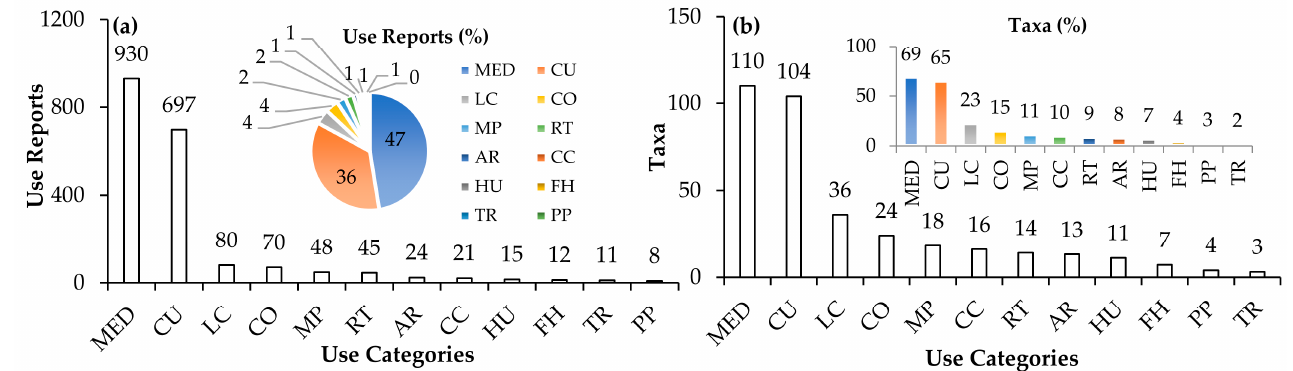
Figure 2. ( a ) The number of use reports (bar chart) and their percentage (pie chart) by use category. ( b ) The number of taxa reported (bar chart) and their percentage of the total number of taxa reported in the ethnobotanical study (colored bar chart) by use category. Use categories: medicinal (MED), culinary (CU), livestock care (LC), cosmetics (CO), manufacture–processing (MP), religious traditions (RT), animal repellent (AR), crop care (CC), household use (HU), fishing–hunting (FH), trade (TR), poisonous plants (PP).